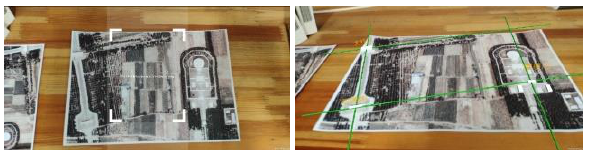
Figure 37. Scan the master plan Figure 38. Site’s selection of Zhaoxi-ling